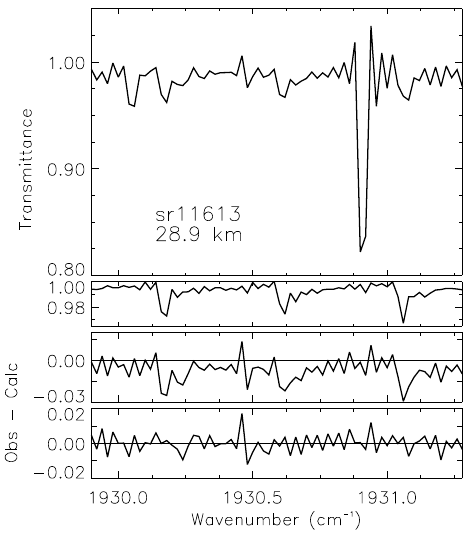
Figure 1. Top panel: an ACE-FTS transmittance spectrum cover- ing the 1929.9–1931.3cm − 1 microwindow for occultation ss11613 (recorded on 9 October 2005 south of Mexico, over the Pacific Ocean) at a tangent height of 28.9km. Second panel: the calcu- lated COF 2 transmittance contribution to the measurement ( ∼ 3%). Third panel: the observed–calculated residuals for the retrieval without the inclusion of COF 2 in the forward model. Bottom panel: the total observed–calculated residuals for the